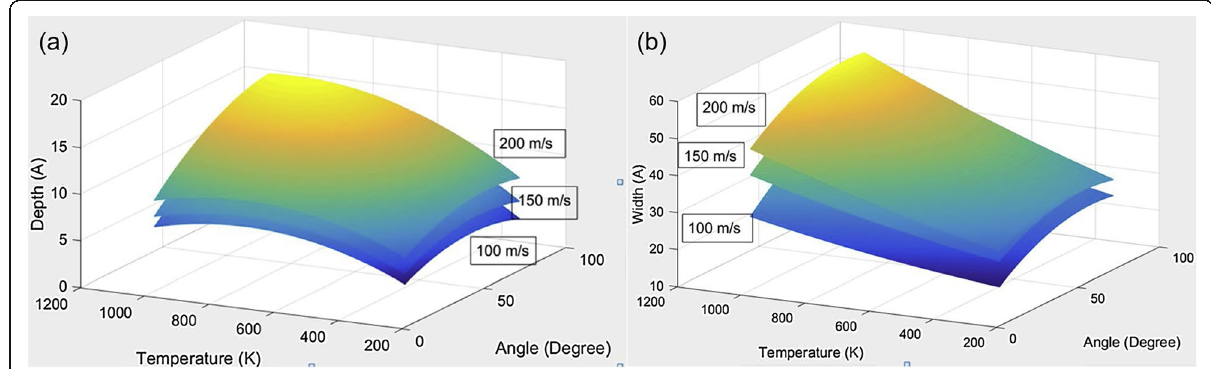
Fig. 4 Multiple linear regression plot for a depth of the nanocavity (impact speed, impact angle, and operating temperature) and b width of the nanocavity (impact speed, impact angle, and operating temperature)